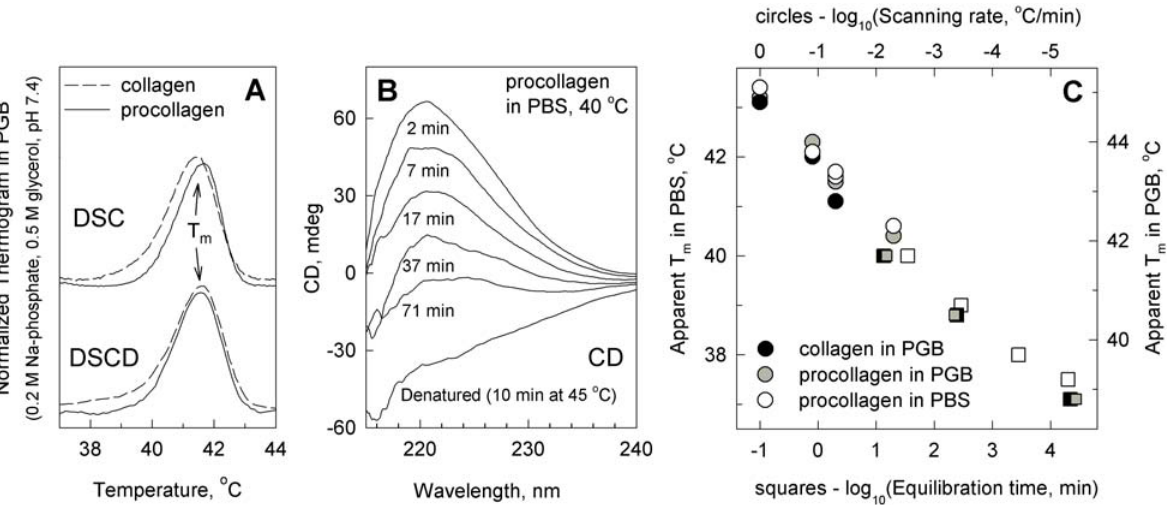
Figure 1. Type I procollagen and collagen have the same thermal stability. A. Denaturation thermograms at 0.05 u C/min heating rate in 0.2 M Na- phosphate, 0.5 M glycerol, pH 7.4 (PGB). B. Procollagen denaturation kinetics at 40 u C in 0.15 M NaCl, 7 mM Na-phosphate, 1.7 mM K-phosphate, pH 7.4 (PBS). C. Apparent T m of collagen and procollagen in PGB and PBS. In DSC and DSCD measurements (circles), T m was defined from the maximum on the corresponding thermogram (as shown in A). In isothermal CD (squares), the time of 50% denaturation was measured at a given temperature (as shown in B) and the results were plotted as the temperature of 50% denaturation (apparent isothermal T m ) vs. the corresponding equilibration time.